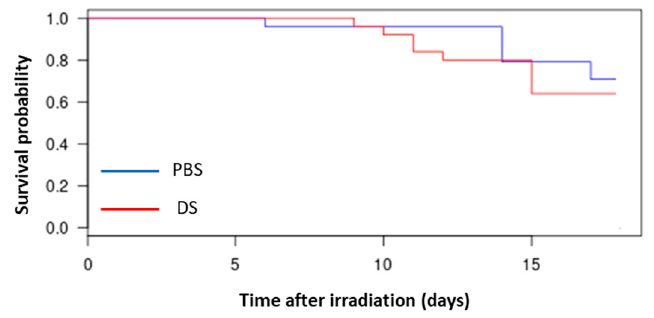
Figure 1. Survival of mice after 7.5 Gy proton TBI irradiation by PBS (Pencil Beam Scanning) or DS (Double Scattering) in the plateau phase of the Bragg peak. n = 24 for PBS and n = 25 for DS.